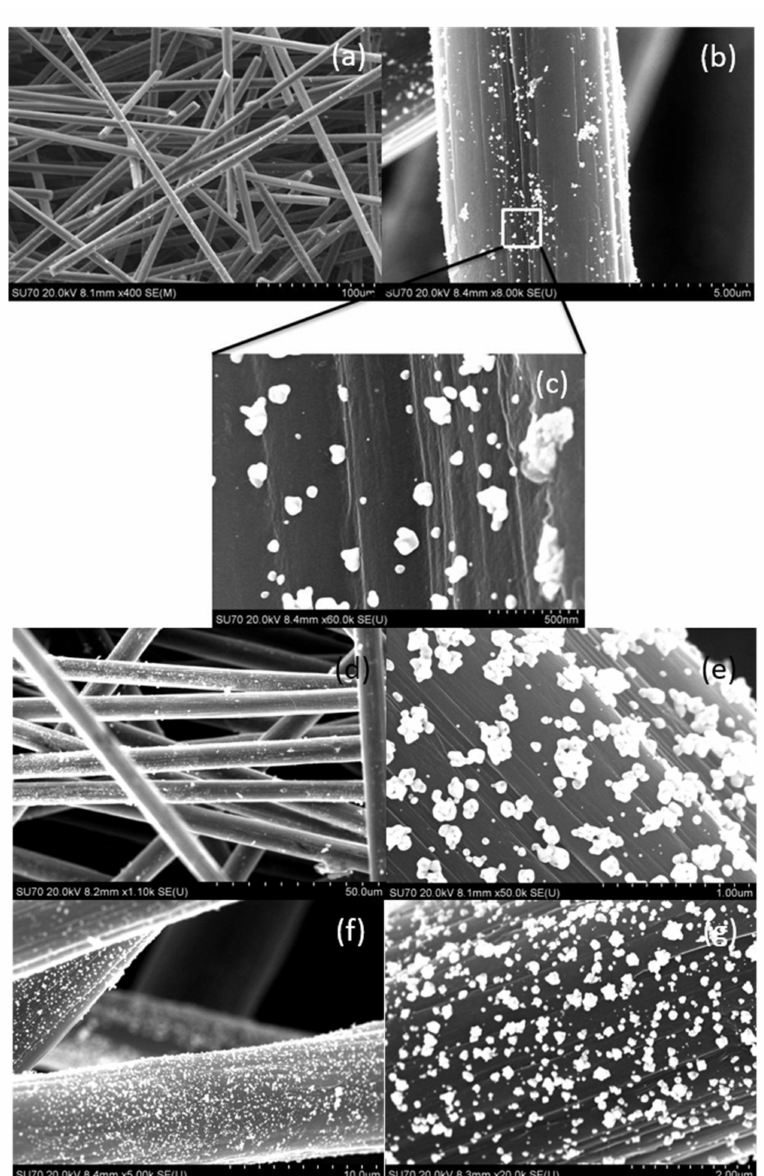
Figure 8. Photos taken with a scanning microscope showing the appearance of activated carbon fibers ( a ) and enlargement of the gold deposition ( b , c ). The synthesis conditions of Au/ACF: C 0, Au(III) = 0.05 mM, C 0, H2Asc = 0.9 mM, ( a – c ); the synthesis conditions of Au/ACF: C 0, Au(III) = 0.15 mM, C 0, H2Asc = 0.9 mM ( d , e ); the synthesis conditions of Au/ACF: C 0, Au(III) = = 0.3 mM, C 0, H2Asc = 0.9 mM ( f , g ). All experiments are without the addition of PVA to the